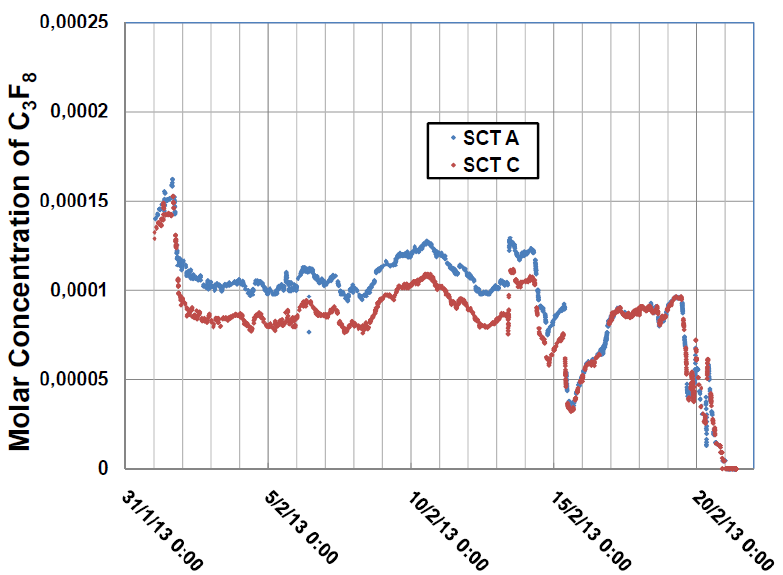
F is shown for the Pixel ( right ) and SCT 3 8